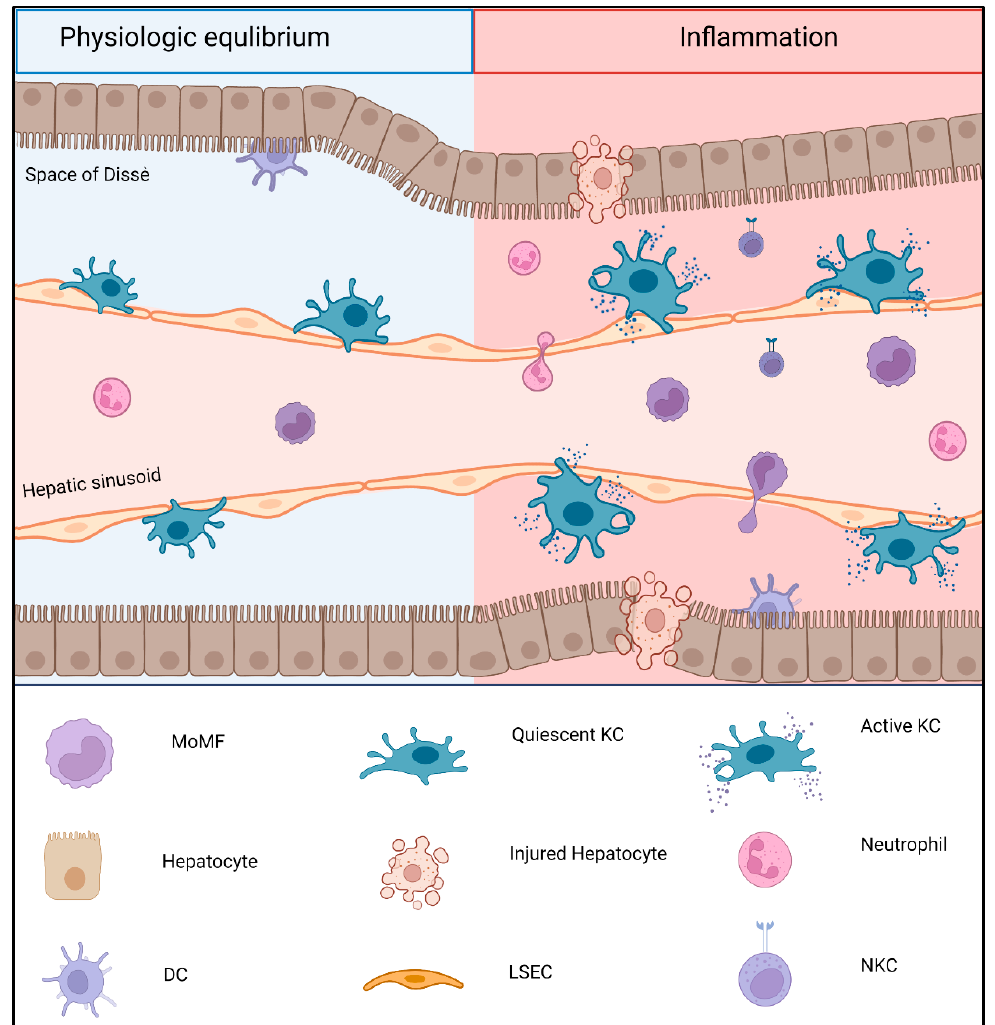
Figure 1. Schematic overview of Kupffer cell (KC) activation states. During the physiologic equilib- rium, KCs remain quiescent and self-maintaining, located next to liver sinusoidal endothelial cells in the space of Dissè, which separates hepatocytes from sinusoidal endothelium. In the absence of inflammatory stimuli, only a small number of monocyte-derived macrophages (MoMFs) are recruited from the hepatic sinusoids. Following an inflammatory stimulus (e.g., ischemia reperfusion injury), a cascade of proinflammatory stimuli and damaged hepatocytes lead to an increasing macrophage activation, large numbers of MoMFs, and neutrophils invading the hepatic tissue. The in- teraction of dendritic cells, natural killer cells, neutrophils, and KCs aggravate inflammation and tissue damage. (Created with BioRender.com, accessed on 24 September 2022).